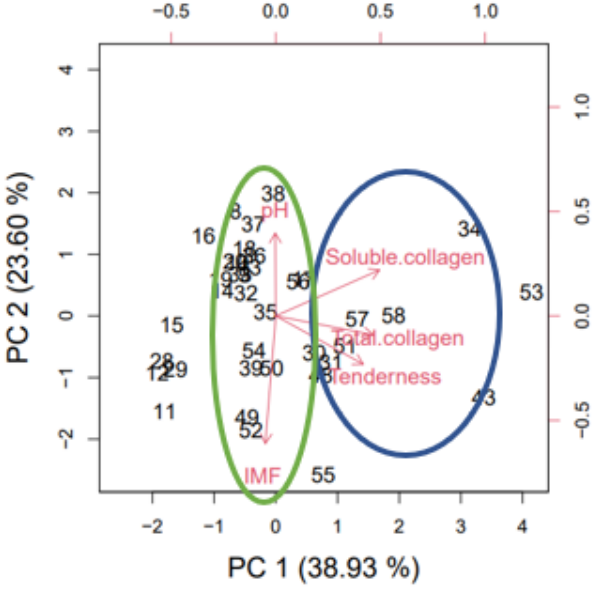
Figure 5. Results obtained from the PCA carried out with Rstudio for the meat attributes under